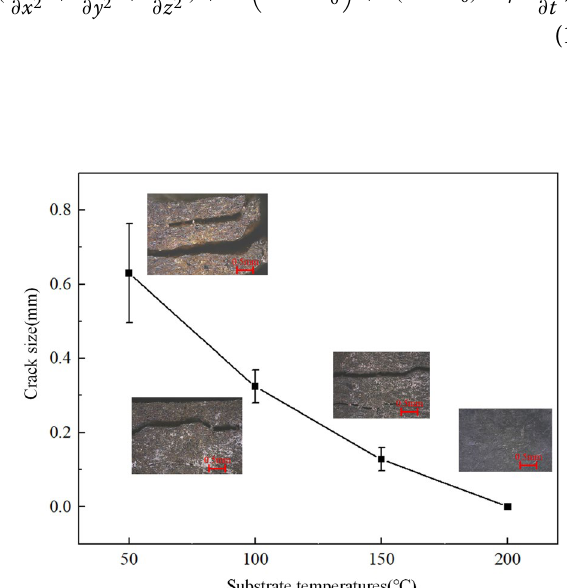
Figure 14 Crack sizes at different substrate